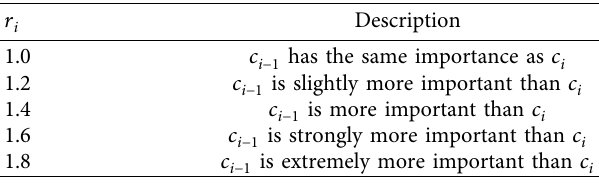
Table 3: The value of relative importance of